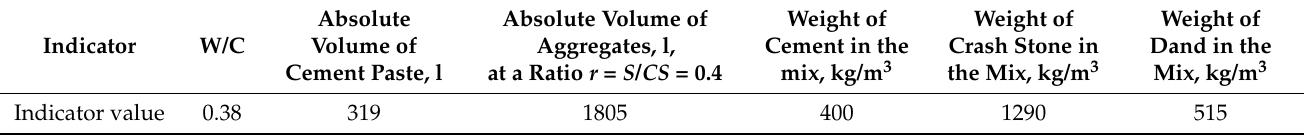
Table 6. Parameters of the composition of the concrete